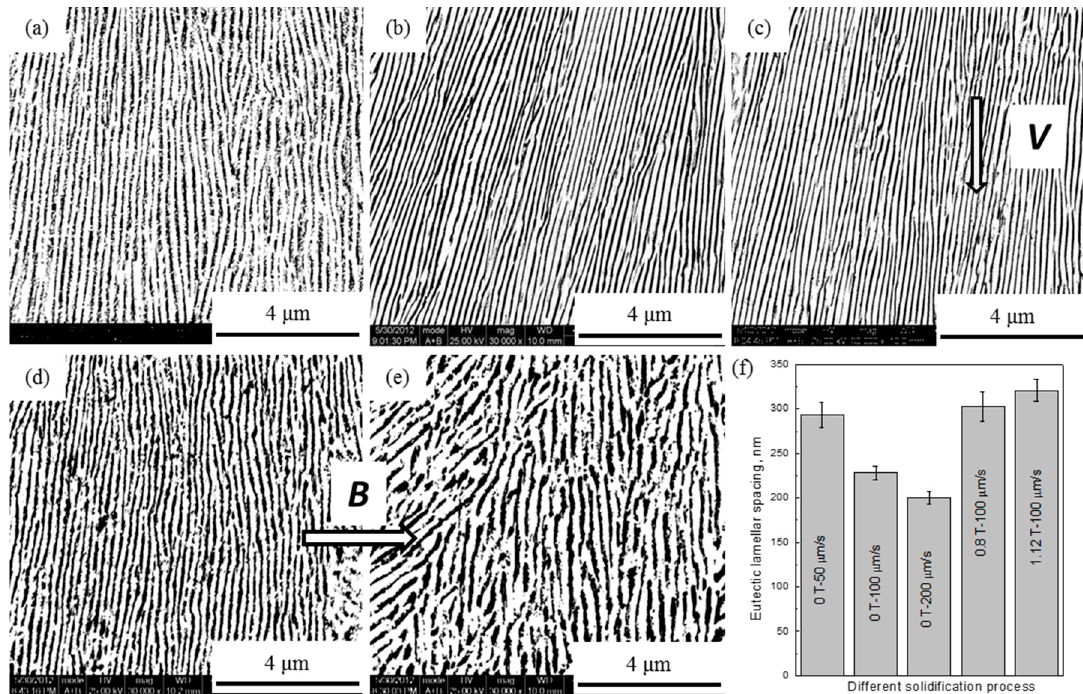
Figure 2. Microstructure of as-DS Ag-Cu eutectic alloys with different MFs ( B ) and different growth rates ( V ) at the constant temperature gradient of 4 K/mm. ( a ) 0 T and 50 µm/s; ( b ) 0 T and 100 µm/s; ( c ) 0 T and 200 µm/s; ( d ) 0.8 T and 100 µm/s; ( e ) 1.12 T and 100 µm/s; ( f ) the quantitative results of the ELS.